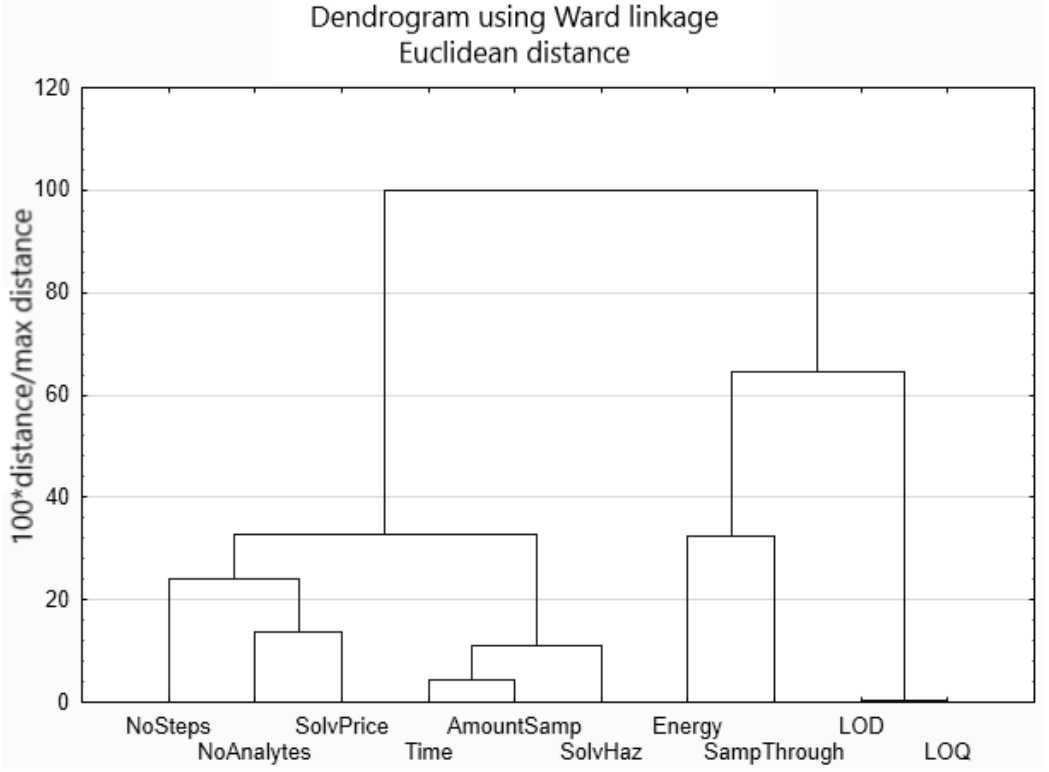
Figure 1. Results of cluster analysis grouping of variables.